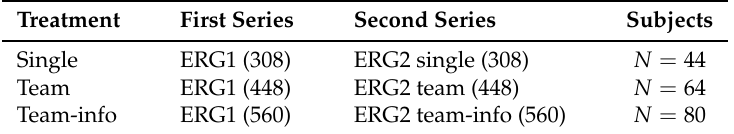
Table 2. Experimental design and number of subjects (number of observations in